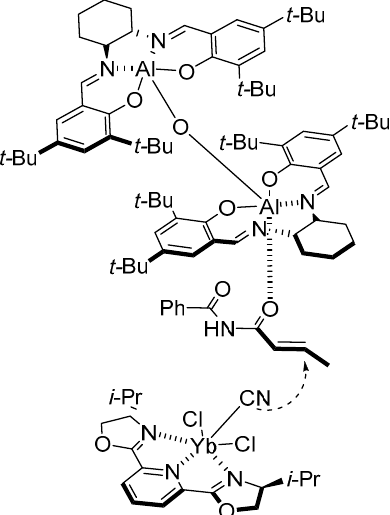
Figure 6. Proposed transition state in the addition of CN to activated unsaturated imides.